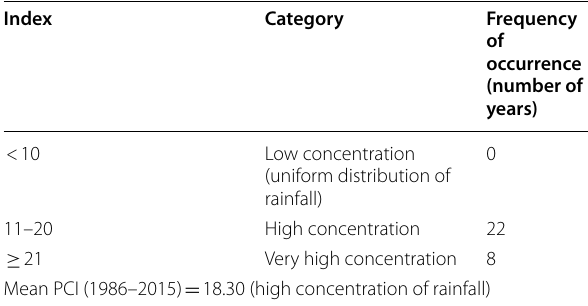
Table 4 Precipitation concentration indices